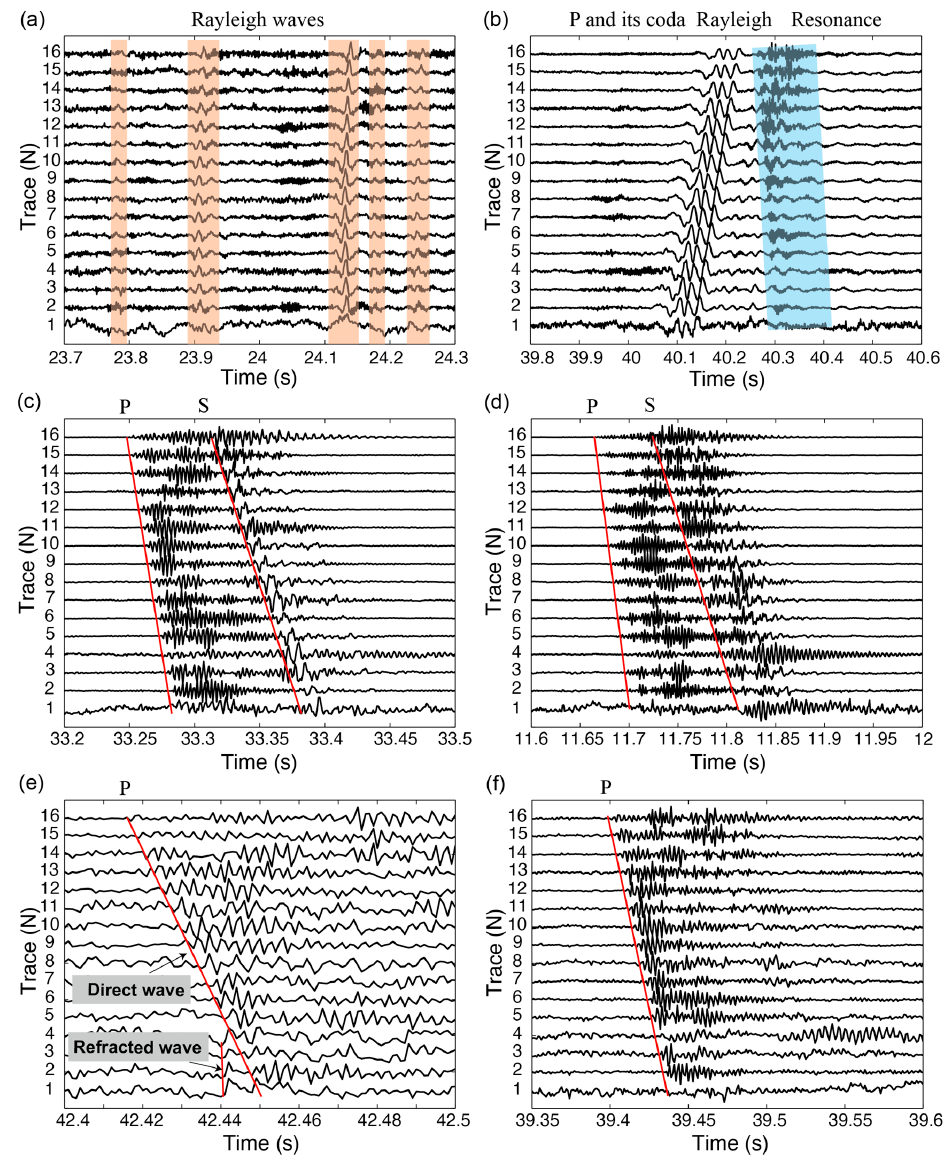
Figure 3. Vertical seismograms of different types of icequakes recorded by the 16 fiber optic seismometers with intervals of 10 m. ( a ) Seismic waveforms of a shallow icequake. ( b ) Seismic waveforms of a hybrid icequake. ( c – f ) Seismic waveforms of four deep icequakes. The waveforms are normalized by individual largest amplitudes. The origin times of seismograms are 23.7 s at 01:26 a.m. ( a ), 39.8 s at 04: 43 a.m. ( b ), 33.2 s at 01:55 a.m. ( c ), 11.6 s at 04:42 a.m. ( d ), 42.4 s at 04:42 a.m. ( e ) and 39.35 s at 01:43 a.m. ( f ) on 8 August 2021 in Beijing time.